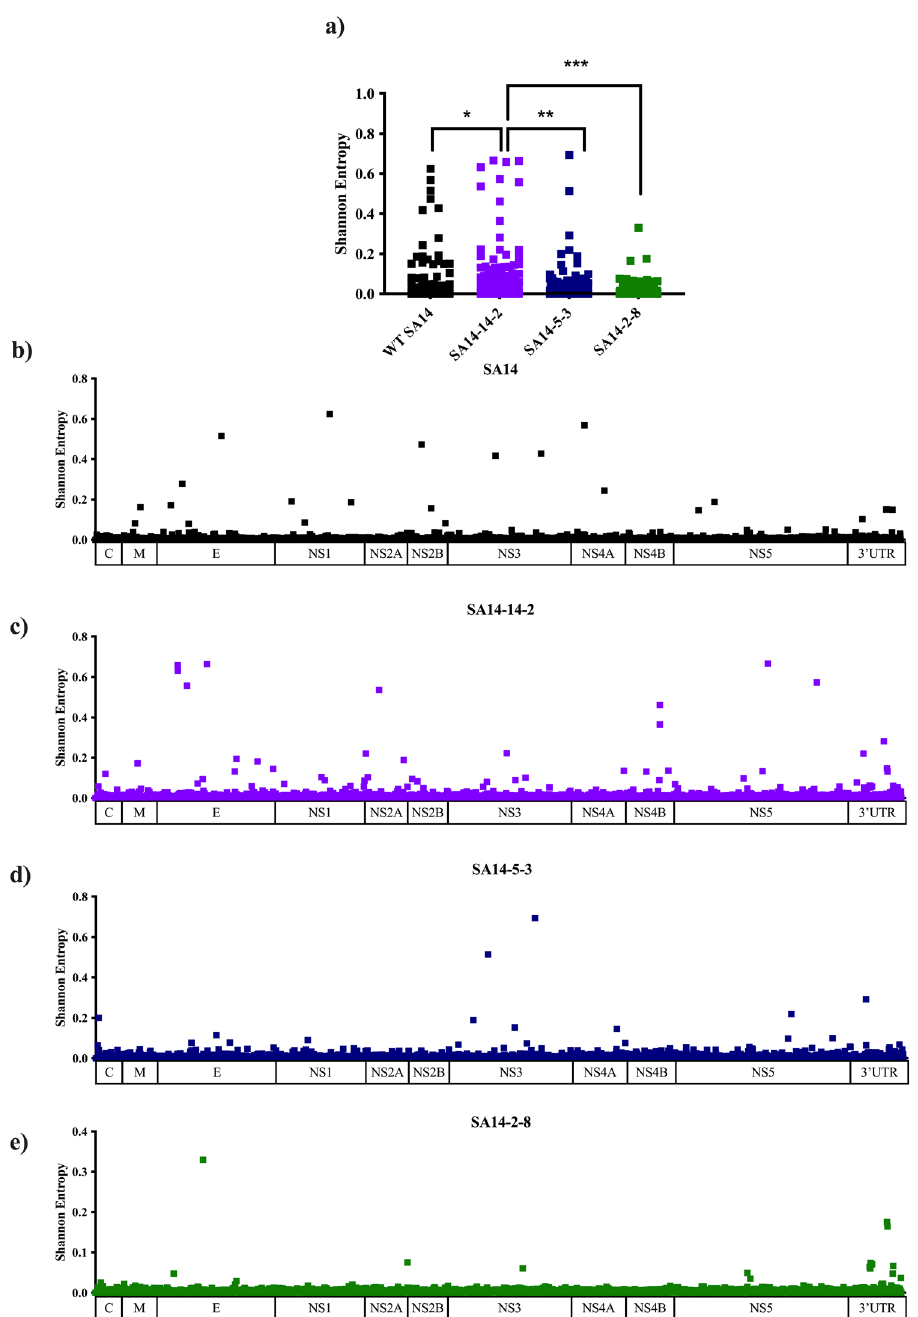
Fig. 4 Genetic diversity of JEV vaccine strains compared to parental WT strain. The genetic diversity of SA14 and the three vaccine strains derived from it was compared through Illumina sequencing methods and quanti fi ed using Shannon entropy ( a ). The Shannon entropy of SA14 ( b ), SA14-14-2 ( c ), SA14-5-3 ( d ) and SA14-2-8 ( e ) were mapped across the genome. All nucleotide positions, UTRs included, are depicted in ( a ): * p = 0.014 (SA14 vs SA14-14-2), **p = 0.0003 (SA14-14-2 vs SA14-5-3) , ***p < 0.0001 (SA14-14-2 vs